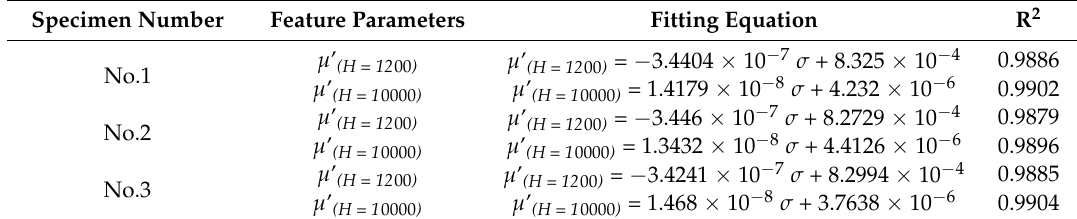
Table 4. The fitting function and R-square of fitted curves µ ’ (H = 12 00 ) ( σ ) and µ ’ (H = 1 0000 ) ( σ ) for different Φ 7 steel